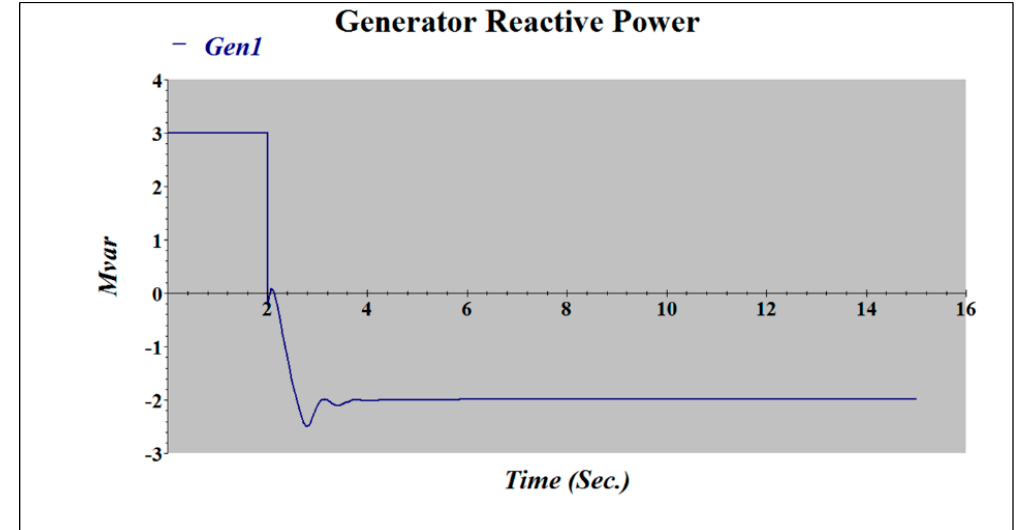
Figure 14. With UEL at − 10% impact in grind.